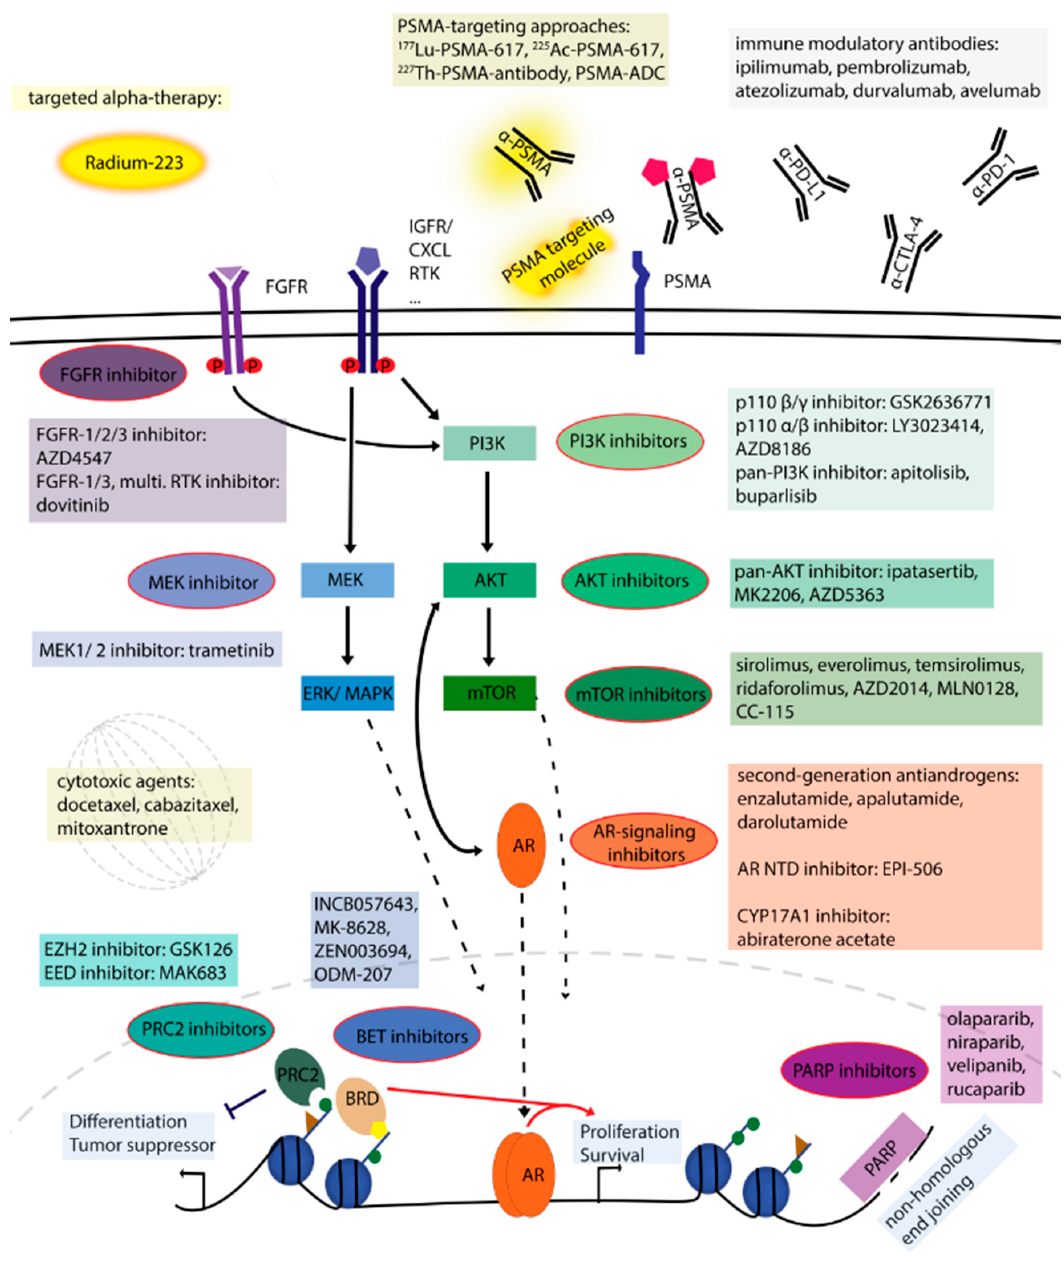
Figure 1. Crosstalk of androgen receptor (AR) signaling with other pathways, and selected inhibitors. Dotted lines were used for cytoplasm-to-nucleus signaling. The red arrow indicates the formation of a protein complex.